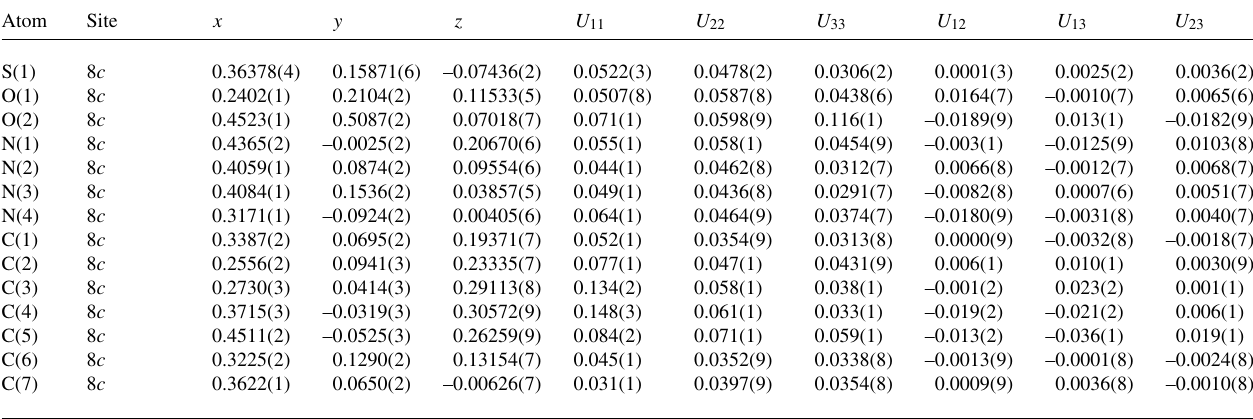
Table 3. Atomic coordinates and displacement parameters (in Å 2 )